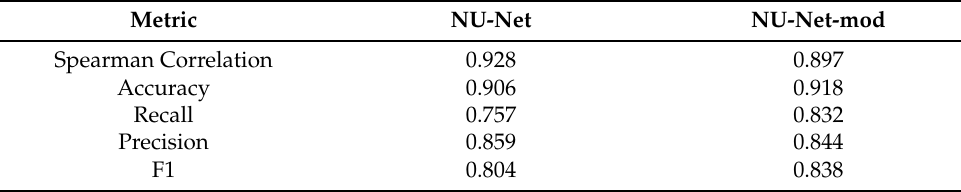
Table 4. NU-Net and NU-Net-mod metric